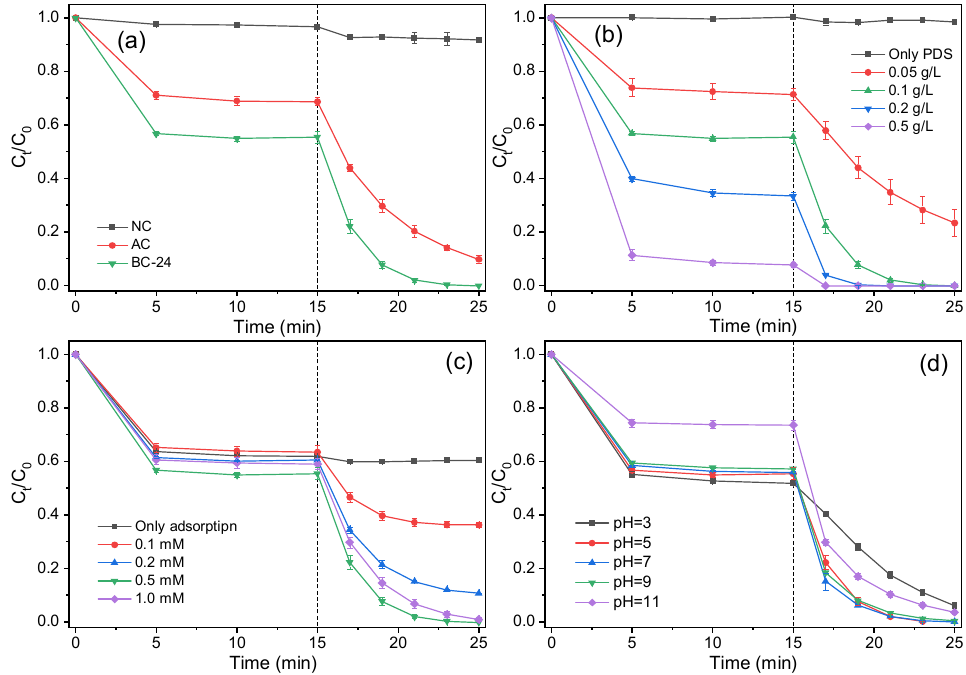
Figure 8. Effects of biochar catalysts ( a ), catalyst dosage ( b ), PDS concentration ( c ), and initial pH ( d ) on phenol degradation ([phenol] = 0.2 mM, catalyst dosage = 0.1 g/L, [PDS] = 0.5 mM).